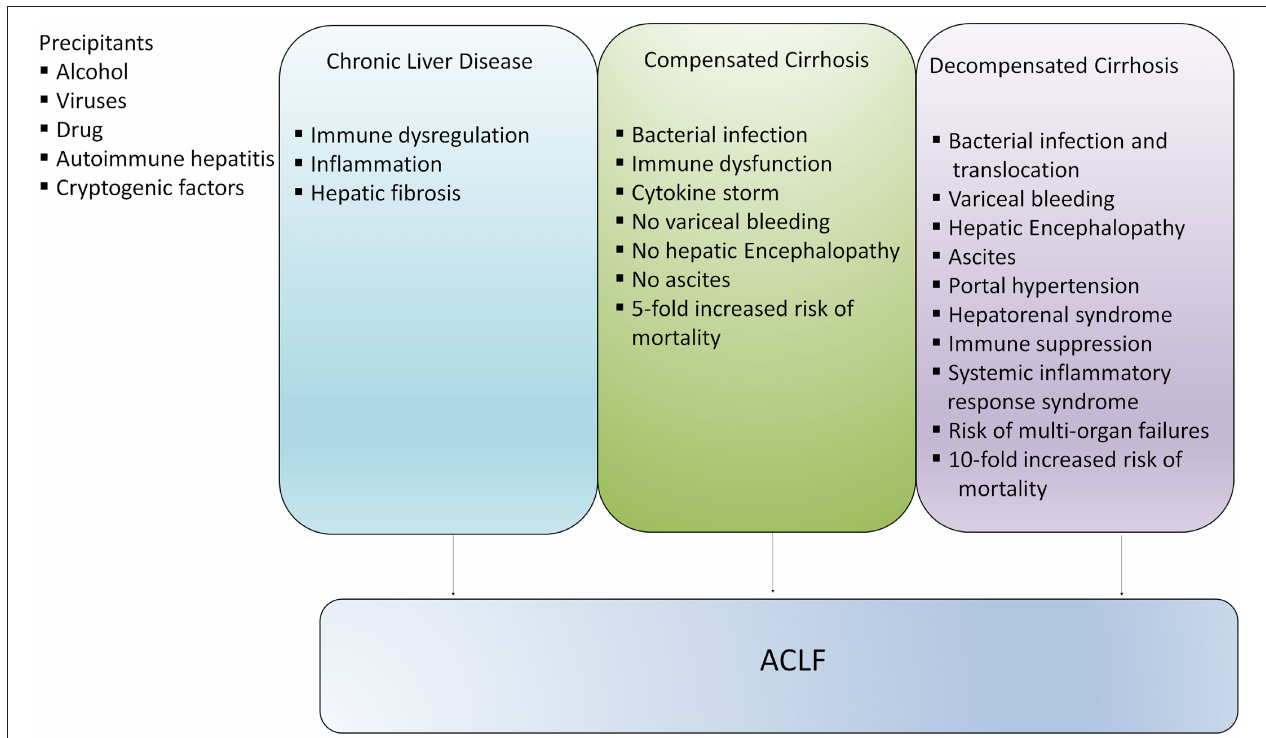
FIGURE 1 | Development of ACLF in different stages of liver disease. ACLF can develop directly in patients with chronic liver disease (CLD), compensated and decompensated cirrhosis or it may progress slowly from CLD to compensated and decompensated cirrhosis and eventually develop into ACLF. However, development of ACLF in patients with compensated and decompensated cirrhosis inflict higher risk of